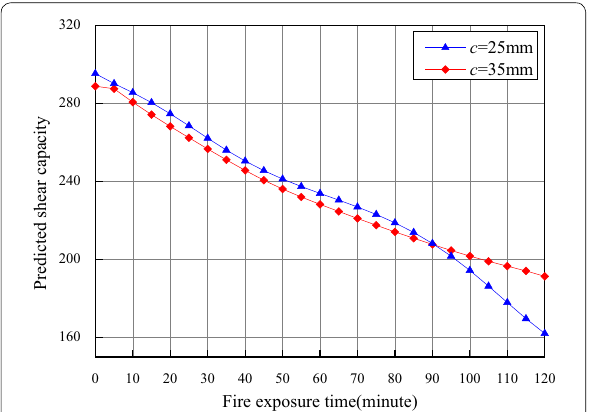
Fig. 11 Effect of stirrup spacing s on shear resistance of beams.